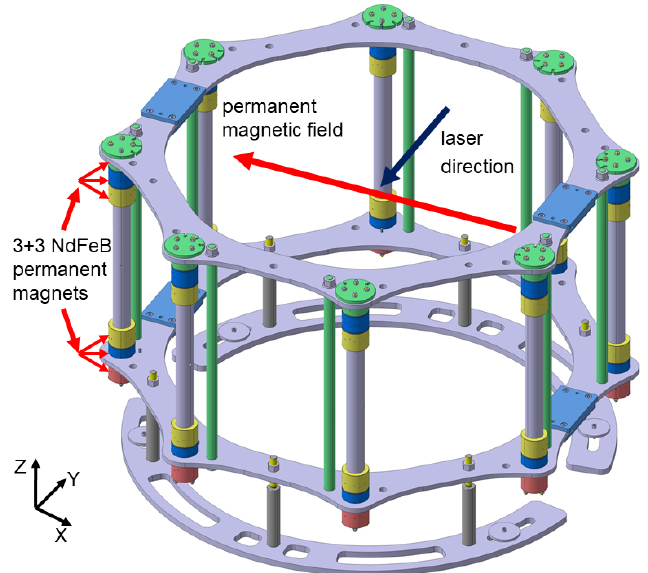
Figure 1. Layout of the permanent magnet